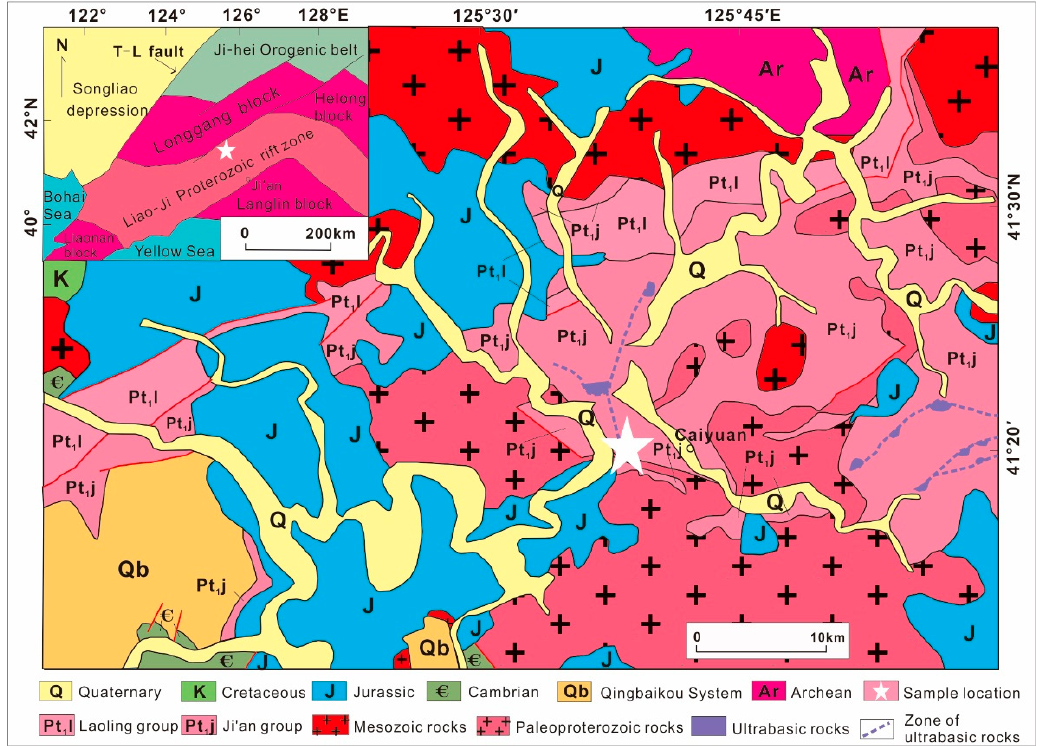
Figure 1. Geological map of the sample-collecting area (after Qin et al. [24]; Zhou et al. [25]). The exact sample-collecting location is indicated by the white star (latitude N41°20'18", longitude E125°39'). The insert shows the major tectonic terranes in a much larger area. T-L fault refers to the Tancheng–Lujiang fault.